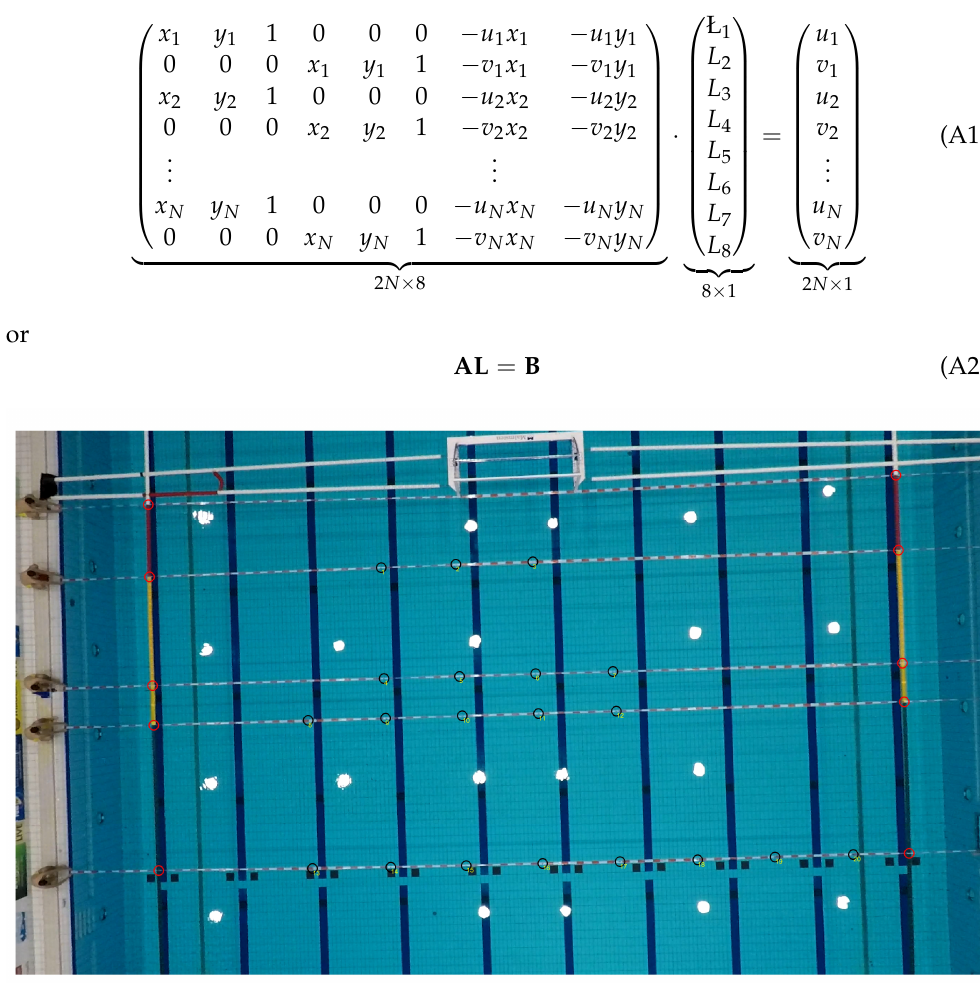
Figure A1. Exemplary calibration points of one half of the